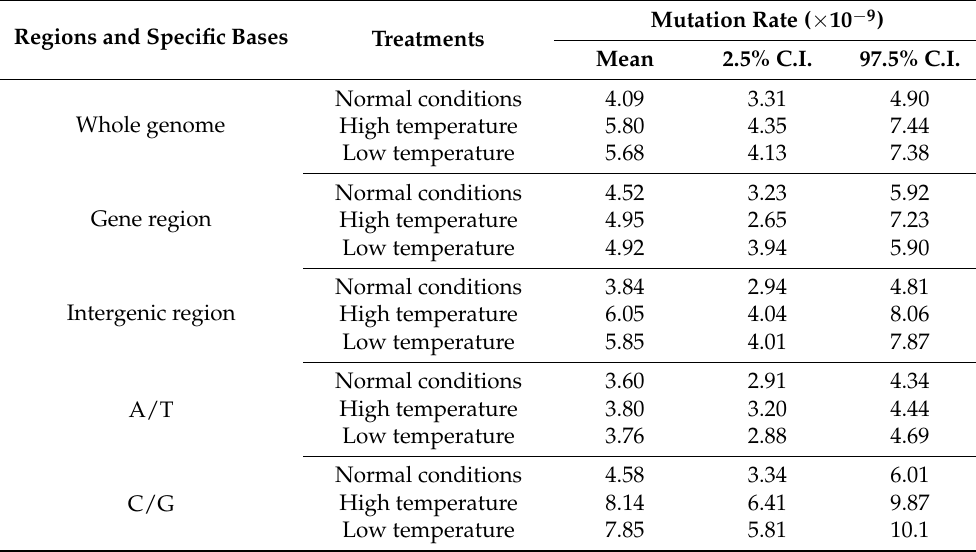
Table 1. The mutation rate of different genome regions and specific bases of the silkworm under different conditions. The 95% confidence interval of the mutation rate was estimated using the bootstrap method with 1000 bootstrap